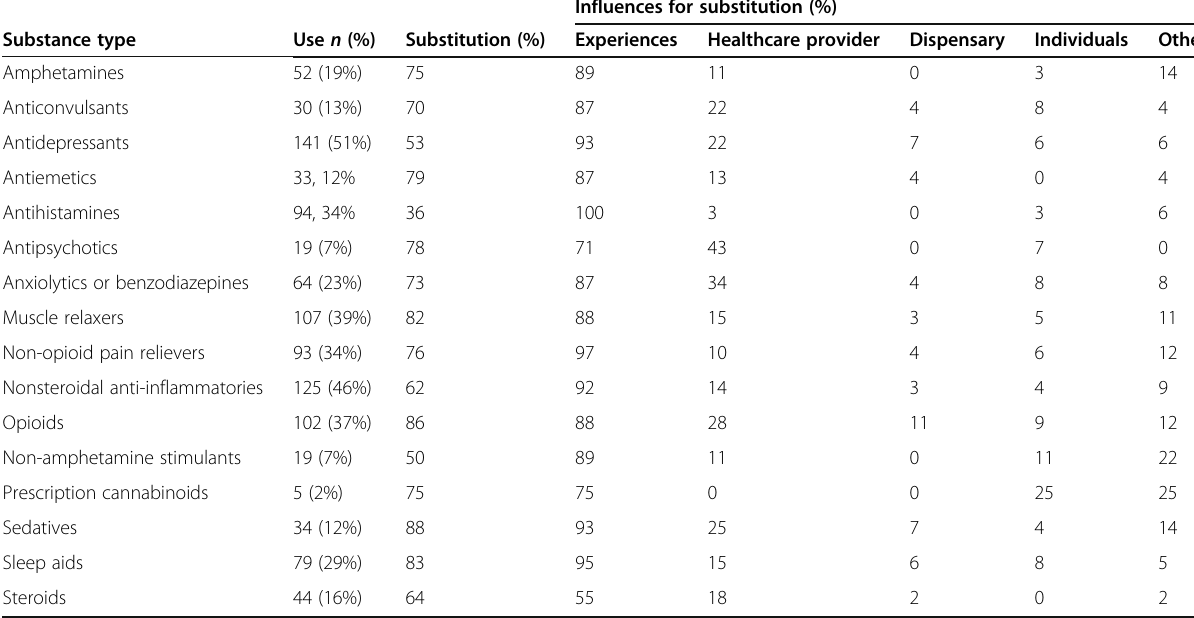
Table 3 Cannabis substitution for pharmaceuticals among 275 Michigan medical cannabis patients, influences for substitution, and primary care provider knowledge of